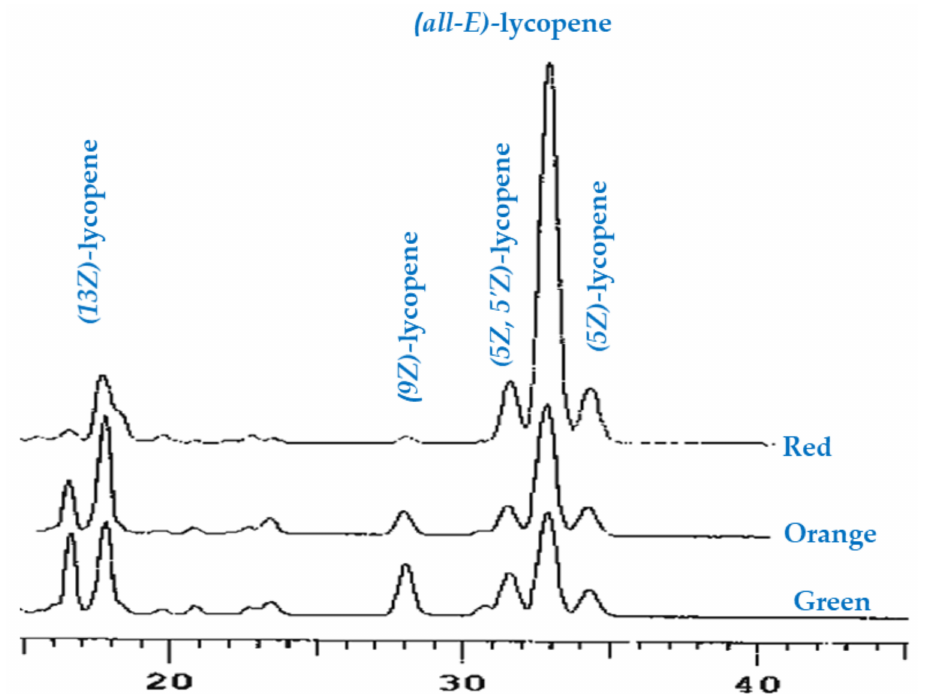
Figure 1. HPLC chromatograms of lycopene isomers in saponified extracts rosehips of R. rugosa at different ripening degrees, using a C30 column and an isocratic mobile